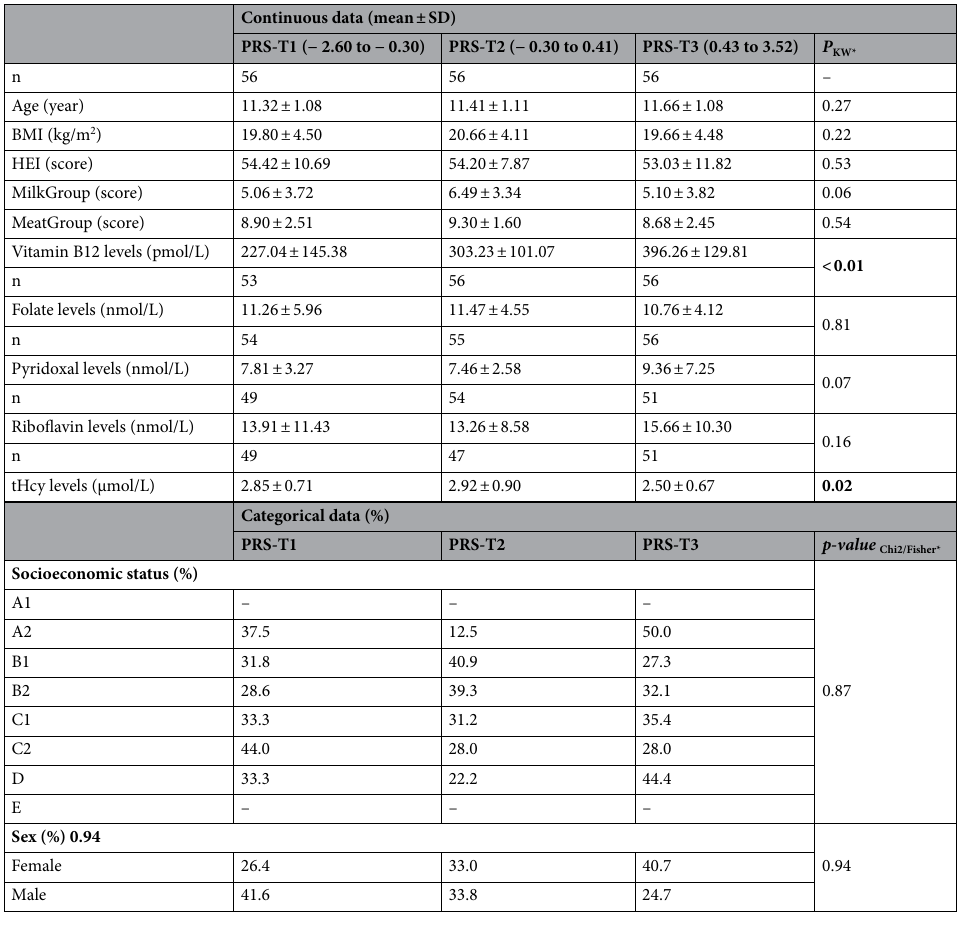
Table 3. Characteristics of individuals according to terciles of polygenic risk score. * p values were calculated by Kruskal–Wallis ( P KW ), Chi-square ( P Chi2 ) or Fisher test. Bold values denote p < 0.05. PRS-T: polygenic risk score tercile. A1 and A2: higher income. B1 and B2: medium income. C1, C2, D and E: lower